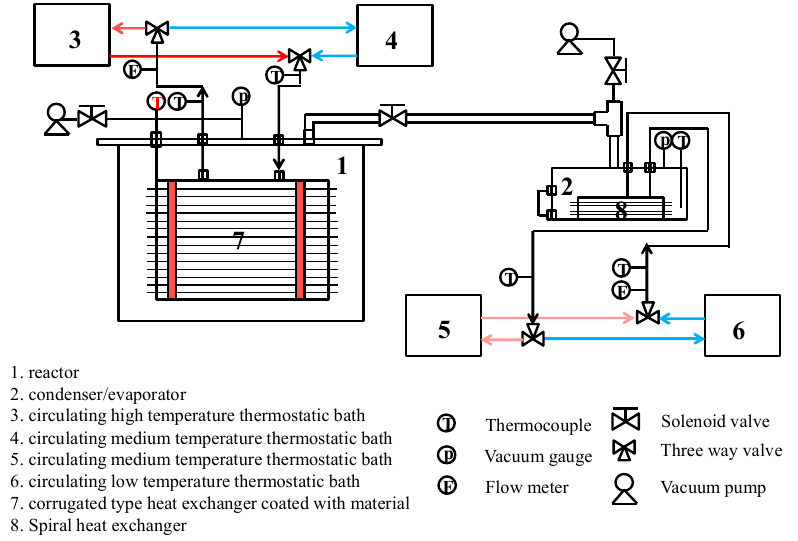
Figure 2. Schematic diagram of experimental setup.